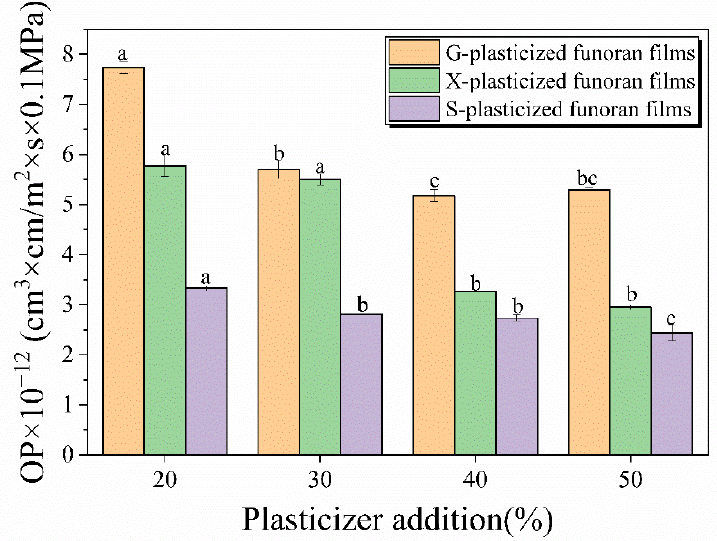
Figure 7. Effects of G, X and S addition on oxygen barrier property of the funoran films. The different superscript letter (a–c) indicates significant